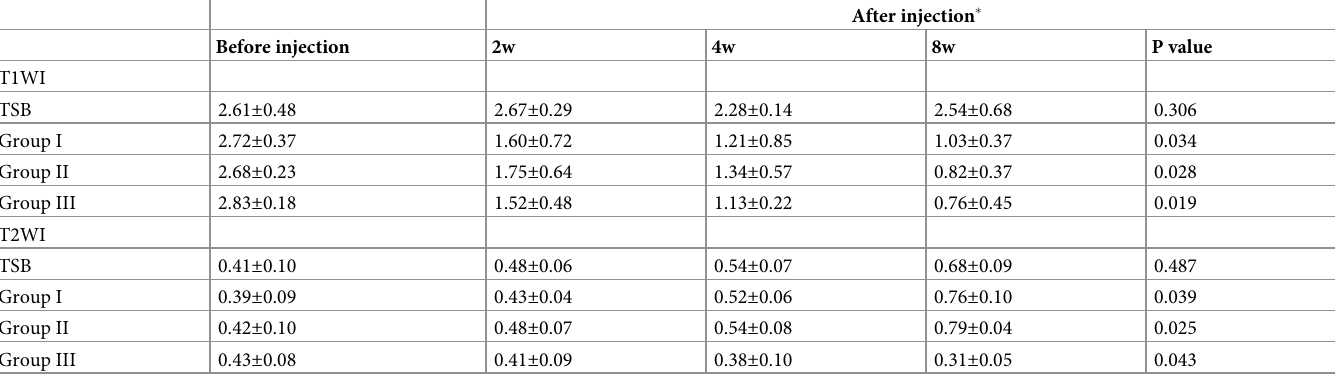
Table 2. Signal intensity (adjusted by cerebrospinal fluid) of endplate region.